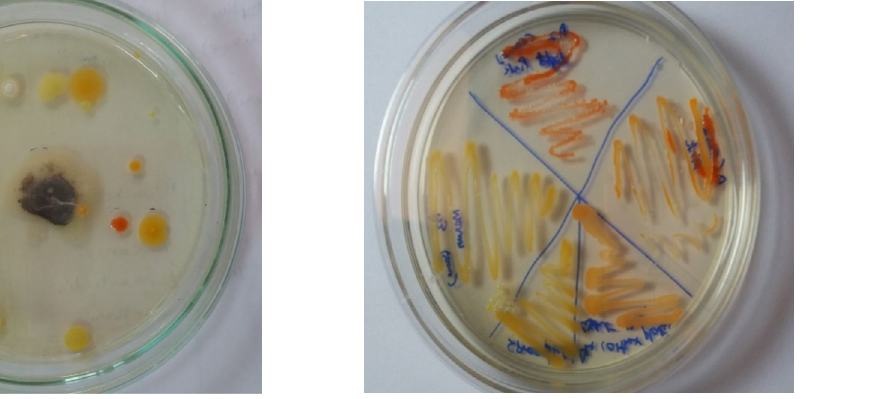
Fig. 1. Picture of growth of microbes on Agar plate with specified culture time of 48hours.